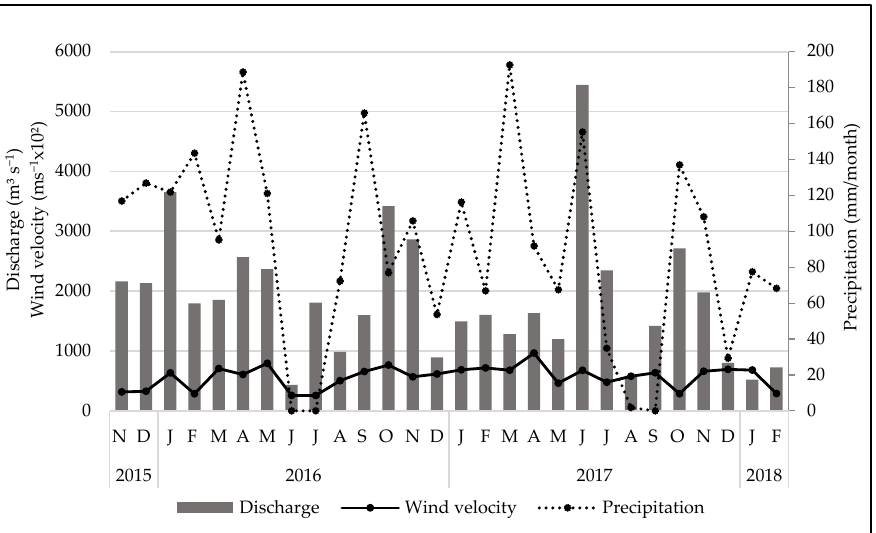
Figure 2. Average fluvial discharge, precipitation (30 days prior to each collection) and wind speed (3 days prior to collection) during the study period (November 2015 to February 2018).